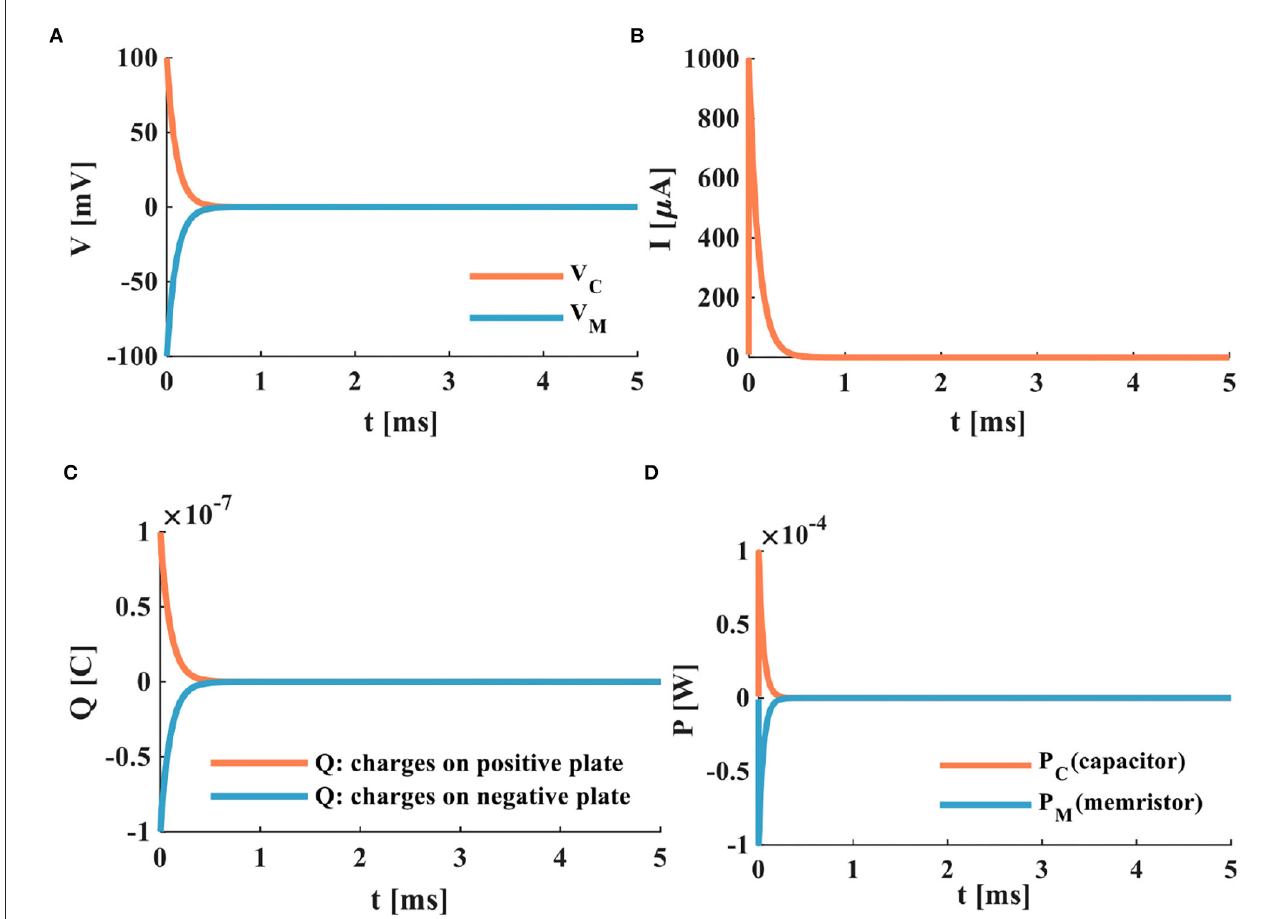
FIGURE 6 | The discharging process of the MC neuron circuit, (A) the membrane capacitor discharging process, (B) the discharging current of the MC neuron circuit, (C) the discharging of charges on positive and negative plates of the membrane capacitor, (D) the power variation of the MC neuron